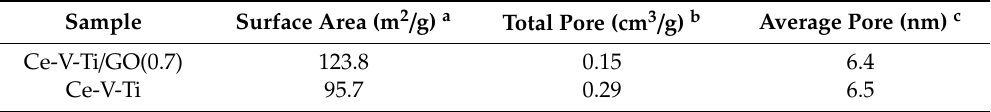
Table 2. Textural properties of the catalysts.